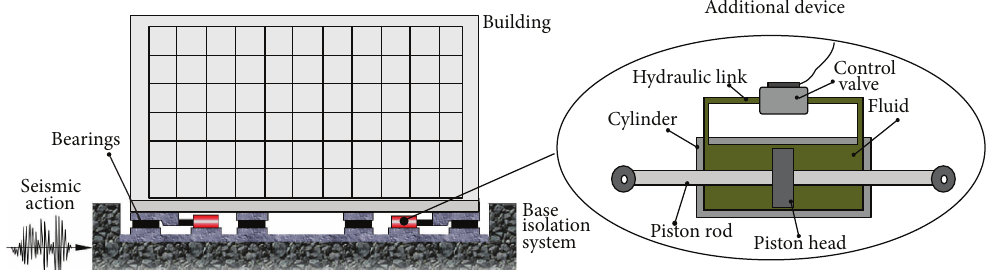
Figure 1: Hybrid system: base-isolated structure with semiactive fluid viscous